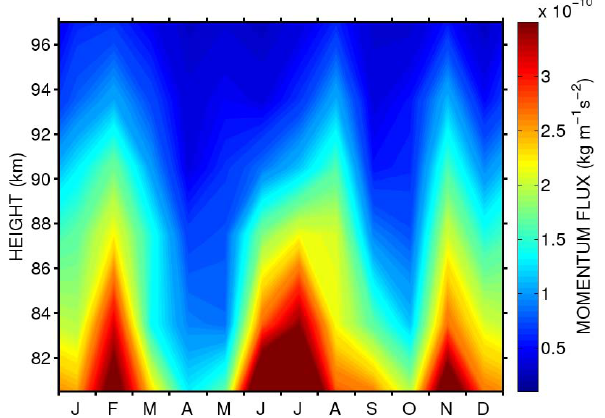
Fig. 14. UFKW Momentum Fluxes for a composite year of data available between 2005–2010 obtained using Ascension Island meteor-radar. Bandpassed winds were used between period limits of 2.5–4.5 days.